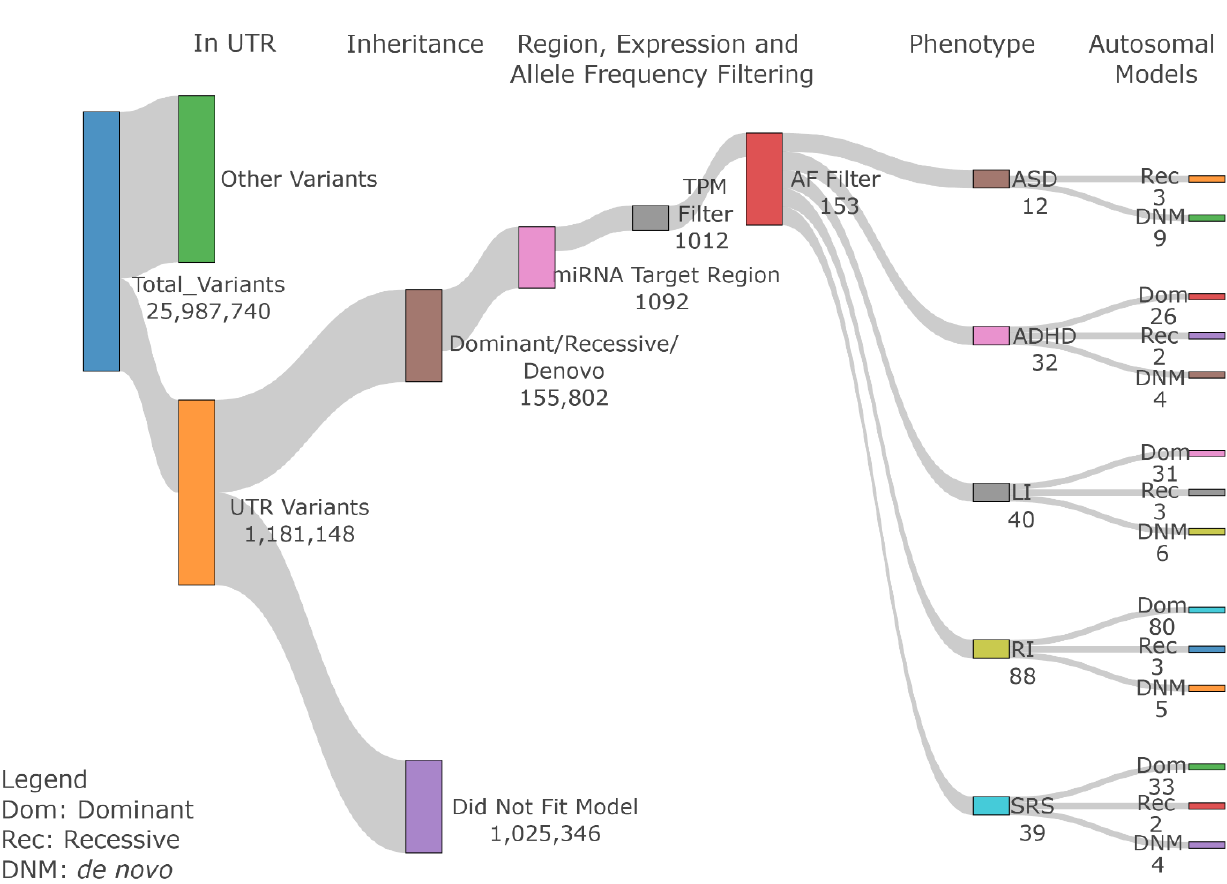
Figure 3. Number of families with 3 ′ UTR variants. Venn Diagrams of families with 3 ′ UTR variants for each inheritance pattern: ( A ) Dominant; ( B ) Recessive; ( C ) de novo . The value indicates the num- ber of families with candidate variants for the phenotype(s). 3.4. Candidate Gene Analysis To understand the functional impact of variants in miRNAs and their binding sites on genes and molecular pathways, we first identified target genes of segregating miRNA variants. We selected genes that are expressed in brain tissues for their biological rele- vance (see Methods for detail). RI had four miRNAs with 284 target genes, and LI had one miRNA with 42 target genes (Table S5). Next, we selected brain-expressed genes contain- ing segregating variants in the 3 ′ UTR miRNA binding sites. A total of 12, 32, 39, 87, and